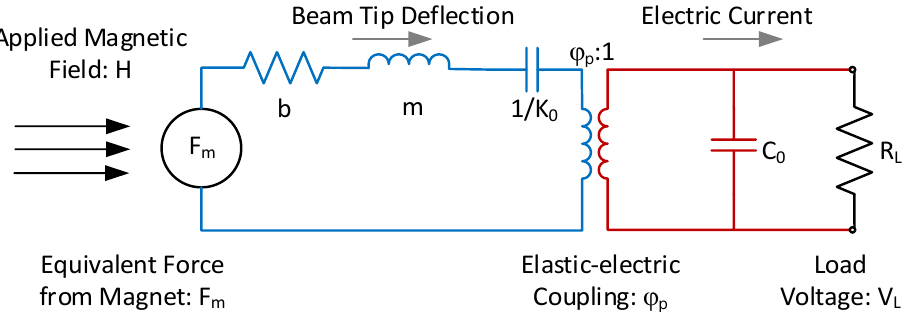
Figure 6. Equivalent circuit model of a double cantilever MME structure.